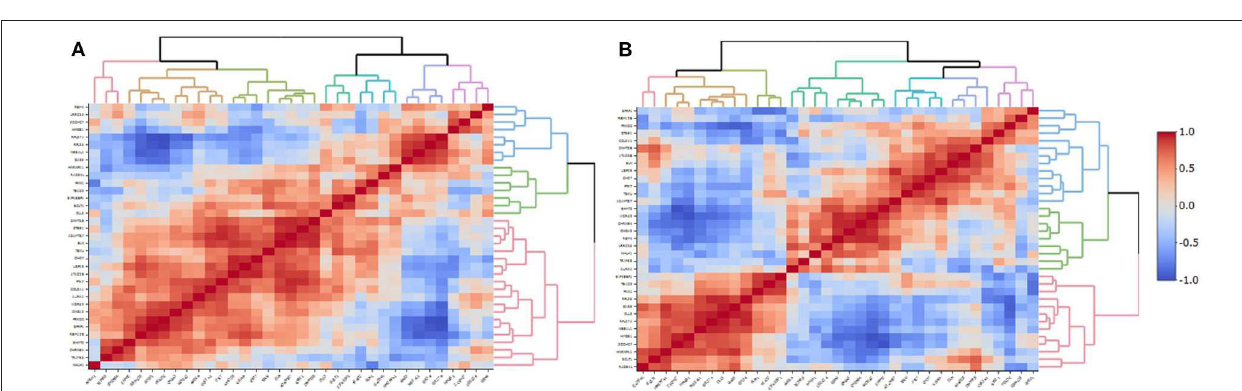
FIGURE 6 | Co-expression of the genes included in the ePRS-5-HTT in the amygdala in the (A) infancy and early childhood, and (B) adulthood periods in humans. Each vertical line represents correlation with a unique gene. Genes from the same expression quantification tend to cluster together and could be visualized in red (positive correlation), or blue (negative correlation) patterns. Infancy and early childhood period ranges from 0 to 4 years of age ( N = 7); Adulthood ranges from 20 to 40 years ( N = 6). Data for this analysis was extracted from